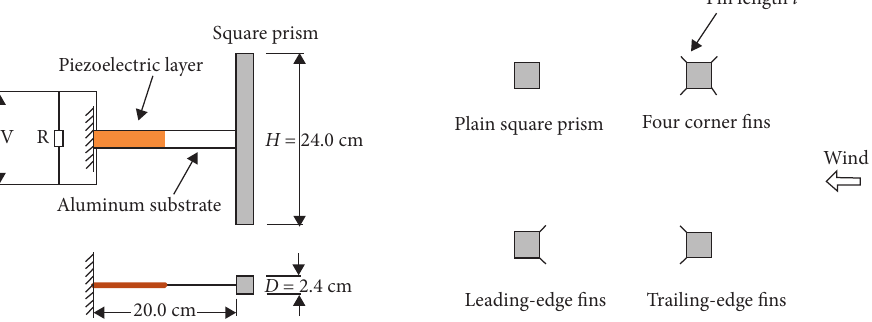
Figure 6: Sketch of the piezoelectric harvester with fins [60].